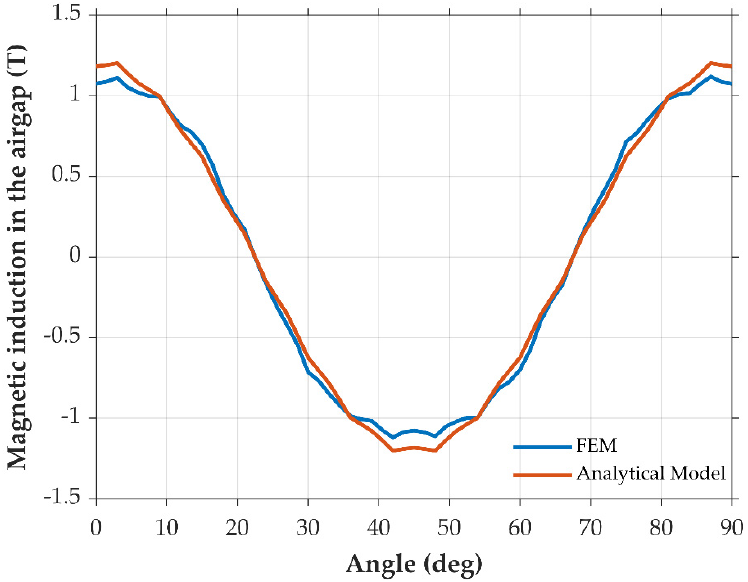
Figure 13. Magnetic induction in the air gap of the machine.